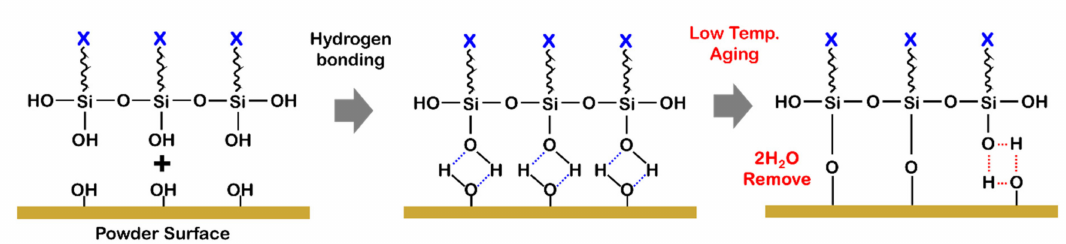
Figure 1. Schematic diagram of the process of bonding a silane coupling agent to a nanopowder